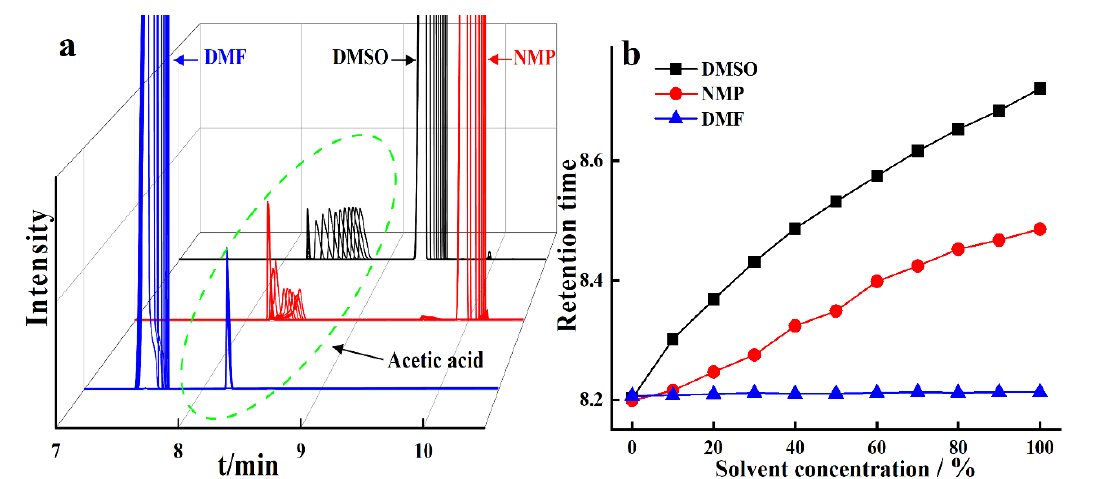
Figure 4. Retention times of acetic acid in three polar aprotic solvents. ( a ) Acetic acid peaks in three polar aprotic solvents; ( b ) changes in retention time of acetic acid in three polar aprotic sol- vents.